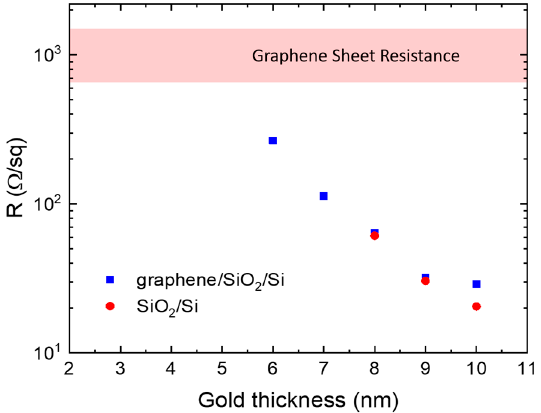
Figure 3. Dependence of the sheet resistance of gold films on their thickness for the two types of substrates. Nanomaterials 2020 , 10 , x FOR PEER REVIEW